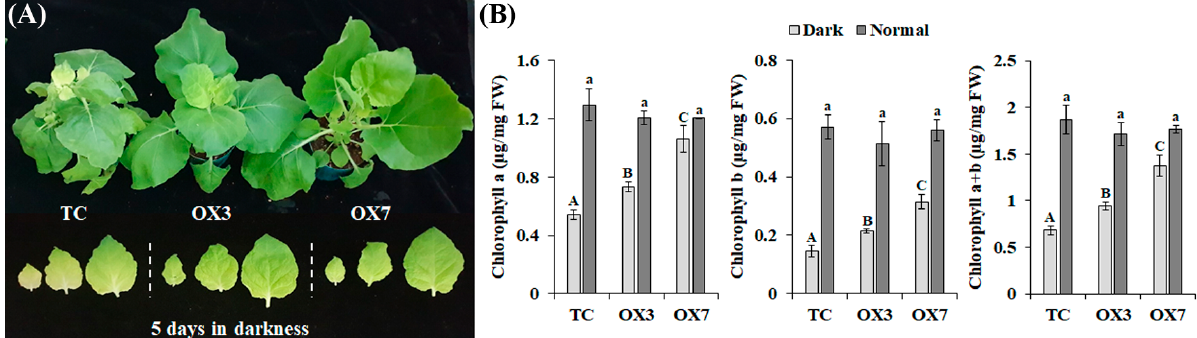
Figure 4. BrbZIP-S overexpression delayed darkness-induced senescence in N . benthamiana plants. (TC) plants after five days in darkness. ( B ) Chlorophyll (Chl) contents of plants were determined. Uppercase denotes significance between the Chl levels under darkness, whereas lower-case denotes significance between the Chl levels under normal conditions (Duncan’s multiple range test, p < 0.05).